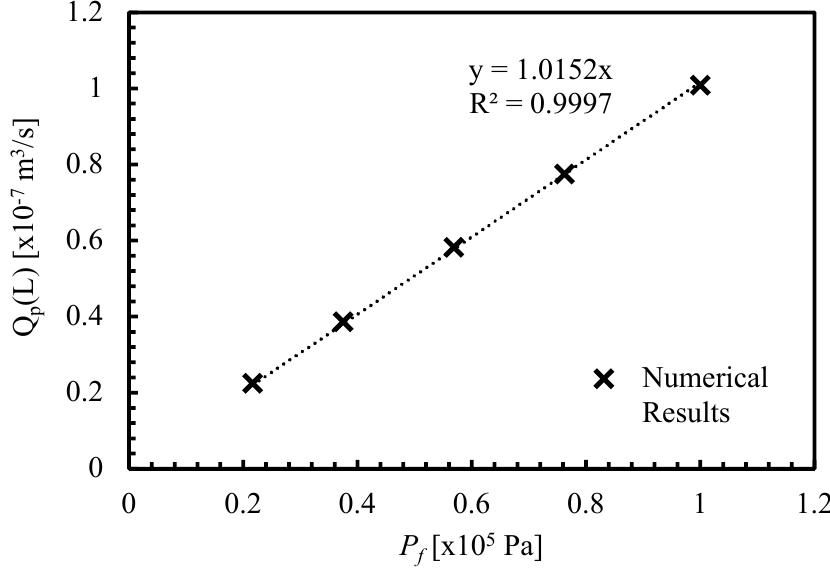
Figure 5. Numerical results presenting permeate flow rate at different feed pressures.